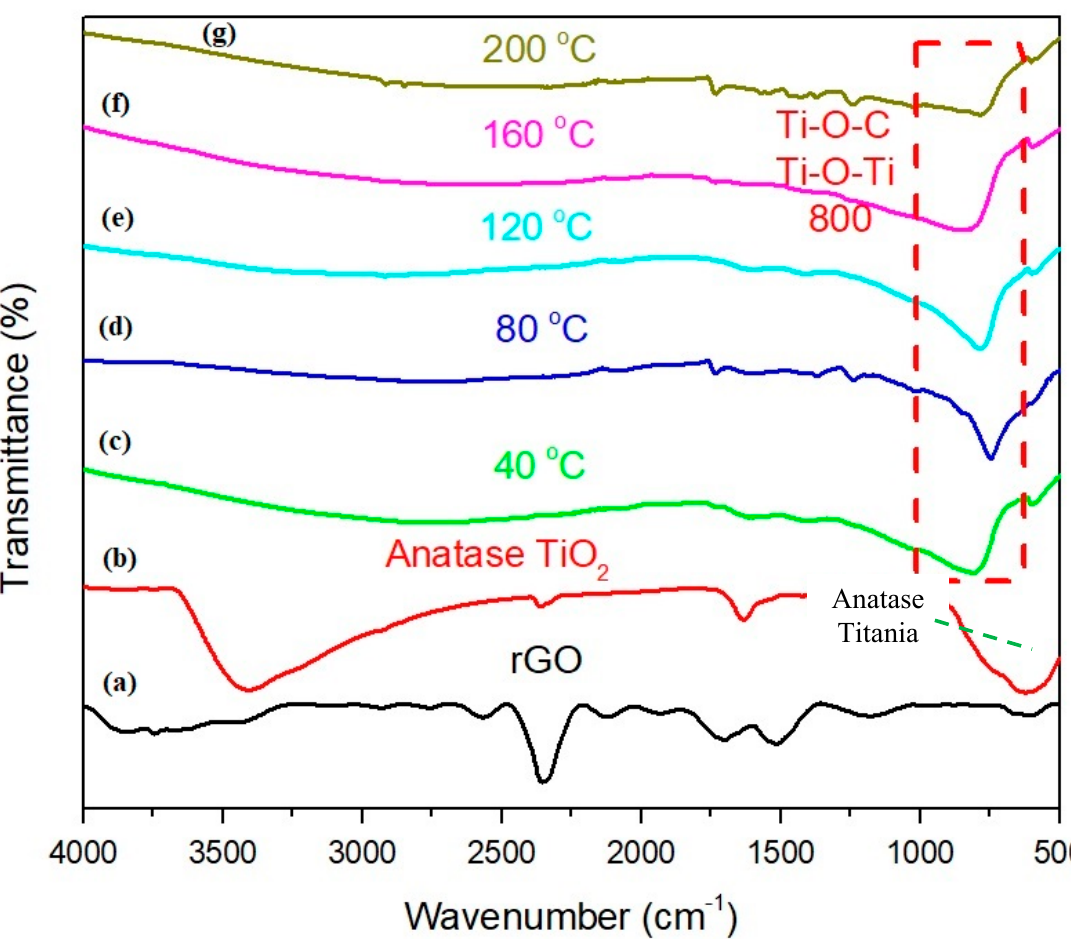
Figure 8. FTIR spectra of ( a ) rGO, ( b ) anatase TiO 2 , and rGO sputtered TiO 2 via different temperature ( c ) 40 °C, ( d ) 80 °C, ( e ) 120 °C, ( f ) 160 °C, and 200 °C.